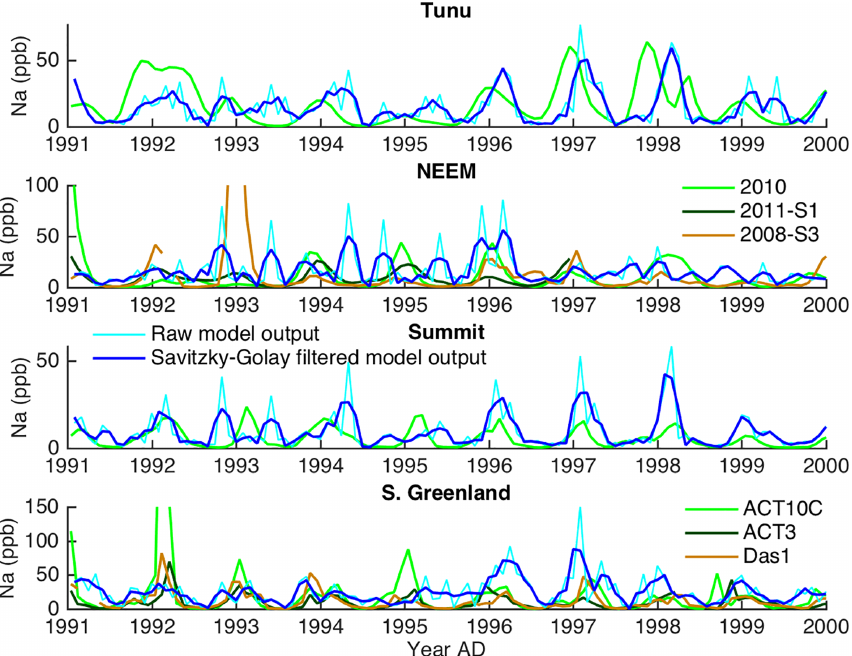
Figure 7. Time series of Greenland ice core [Na] (bright green, dark green, and dark orange) and p-TOMCAT simulated [Na] in Greenland snow 1991–1999 (raw, cyan; smoothed, blue). Data from three different ice cores are displayed on the NEEM and S. Greenland panels because they are located in the same grid square in p-TOMCAT (Table 2). Simulated [Na] is calculated using the constant annual snow accumulation rate indicated by the ice core records in Eq. (5). Simulated [Na] calculated using p-TOMCAT accumulation rates is out of phase with ice core data at some sites (see Fig.